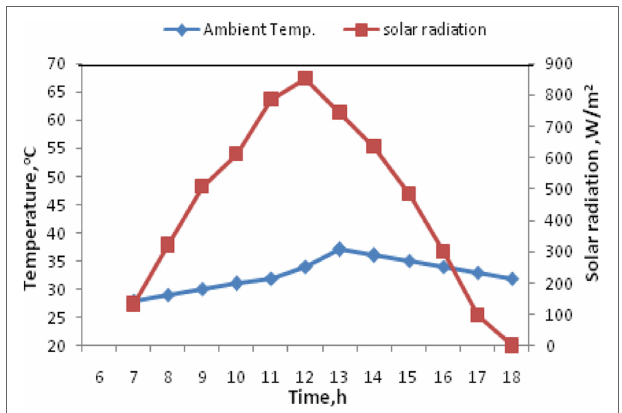
flow water at ambient temperature over the glass surface from